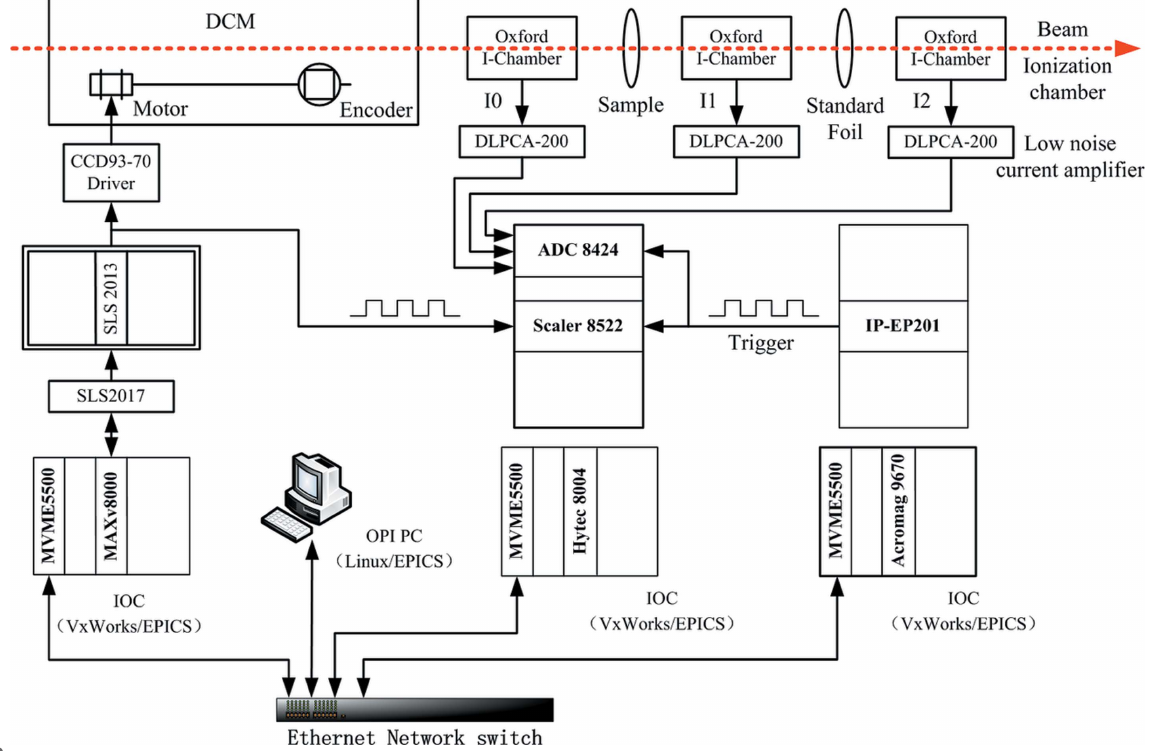
Figure 2 Schematic overview of the QEXAFS system (right-hand part) and the control system of the Bragg motor (left-hand part).